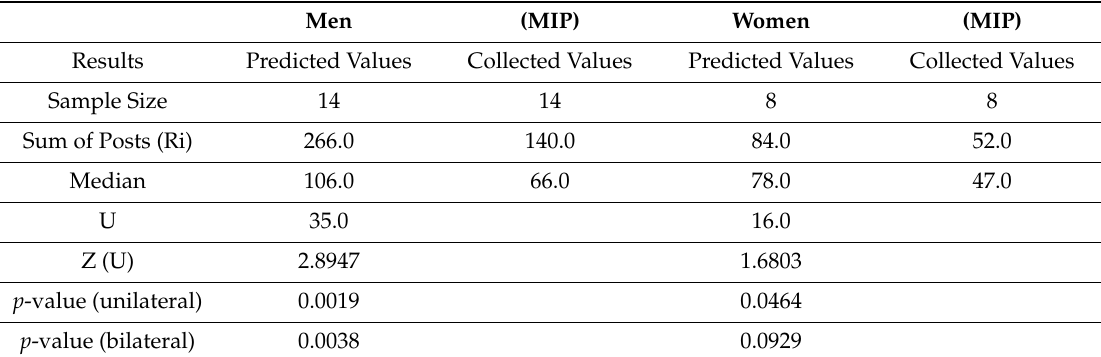
Table 1. Median values for maximum inspiratory pressure (MIP) in men and women.